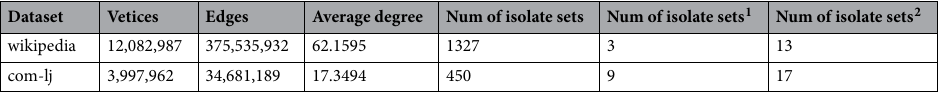
Table 2. Long tail of isolate sets. 1 Num of isolate sets covering 80% vertices. 2 Num of isolate sets covering 90% vertices.